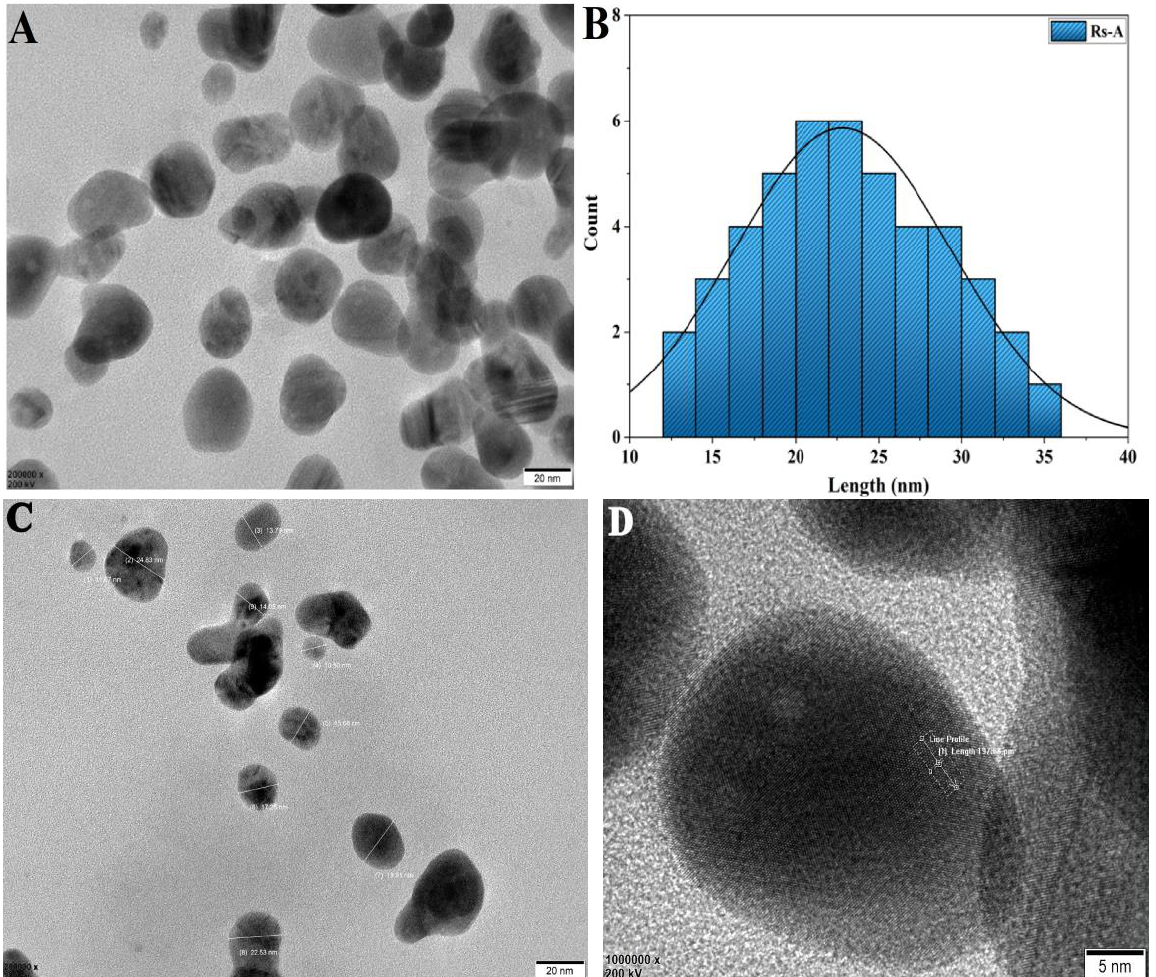
Figure 6. ( A ) TEM micrograph and ( B ) histogram of particle size distribution. ( C ) Selected NPs of the original TEM micrograph for the determination of the size and the shape; ( D ) d-spacing image showing selected area of lattice fringes. showing selected area of lattice